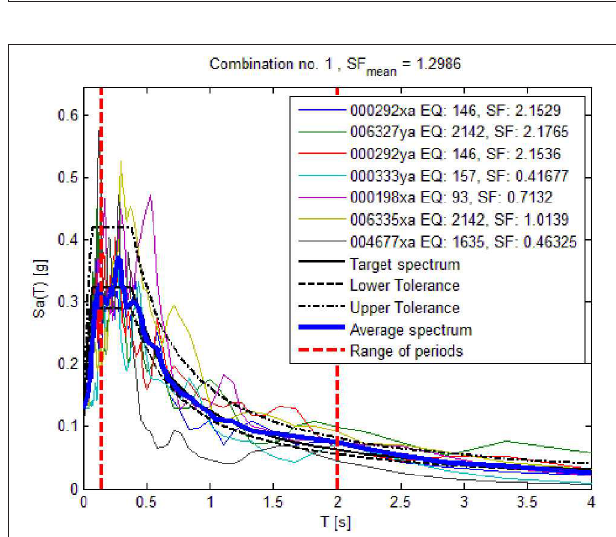
FIGURE 6 | Record spectra, average scaled response spectrum of the accelerograms and NEHRP response spectrum (soft soil) for Tr = 475